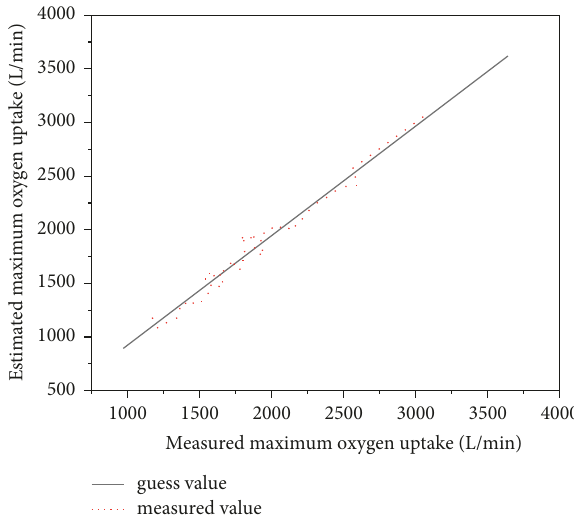
Figure 3: Error analysis of the inferred value and the measured